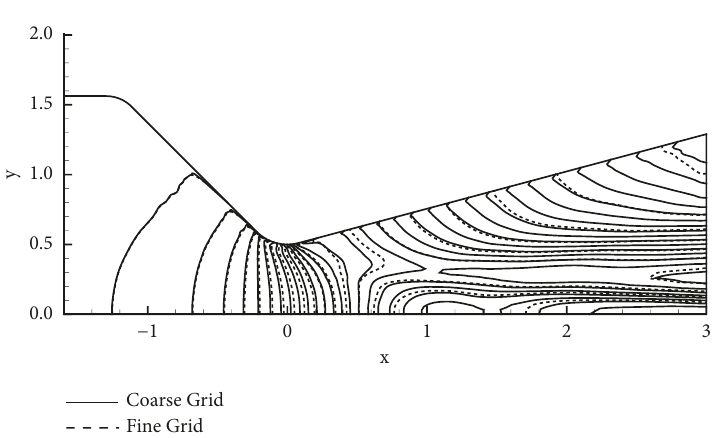
Figure 4: Comparison of Mach number contour lines between two grid